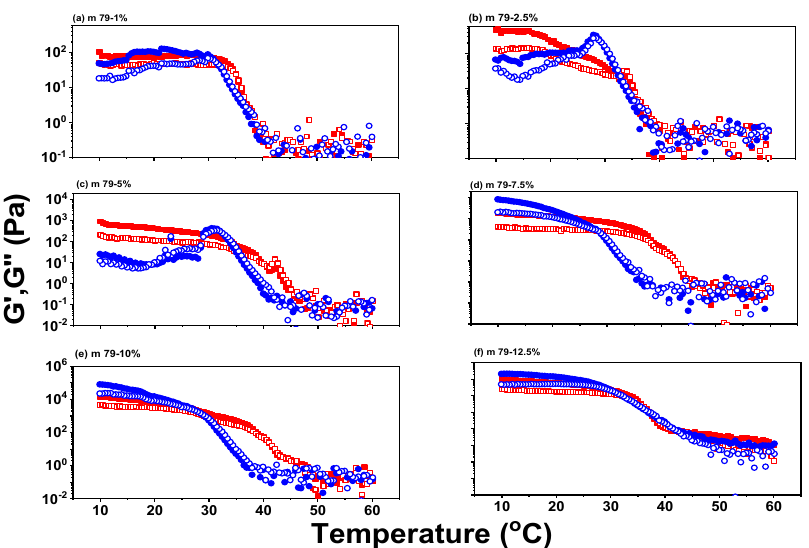
Figure 6. Variations in storage ( G’ , filled symbol) and loss ( G” , open symbol) moduli for m79 solutions at concentrations of ( a ) 1%, ( b ) 2.5%, ( c ) 5%, ( d ) 7.5%, ( e ) 10%, and ( f ) 12.5% as a function of temperature at a frequency of ω = 10 rad/s and a strain amplitude of γ = 0.1%. Symbols ( ■ , □ ) and ( ● , ○ ) are for heating and cooling sweeps, respectively.